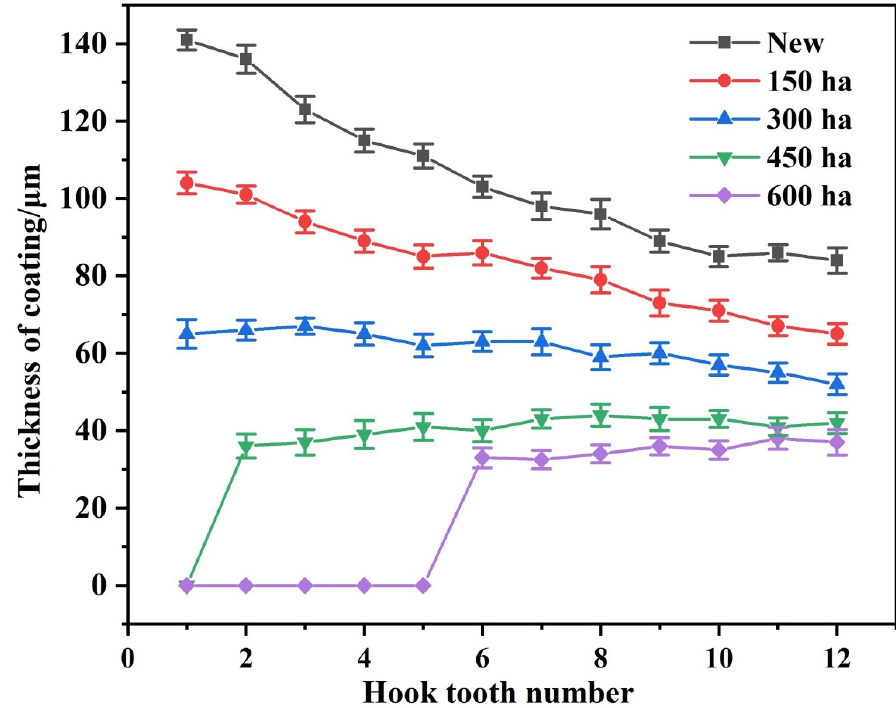
Figure 13. Coating thickness change curve.